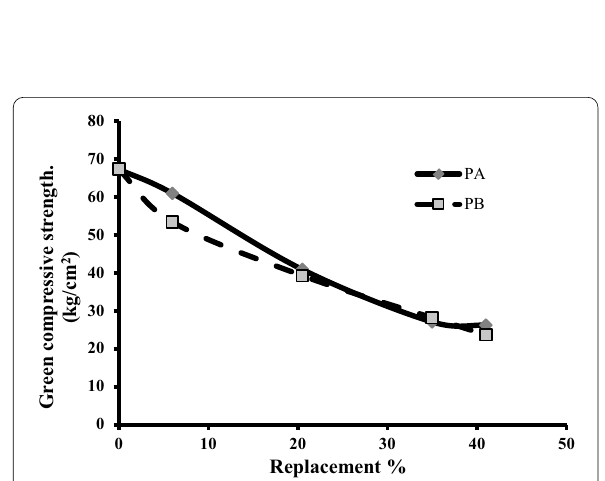
Fig. 6 Green compressive strength for clay‑PA and clay‑PB mixtures